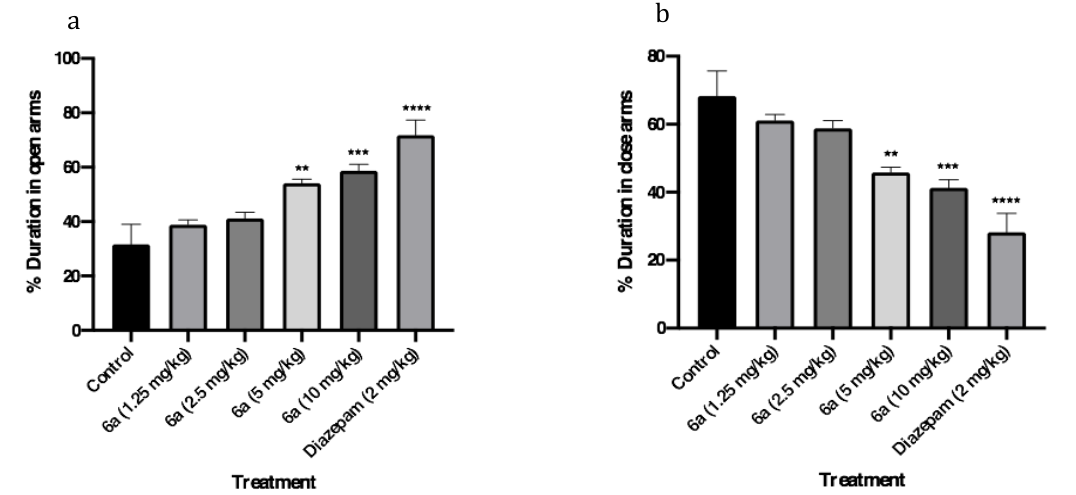
Figure 5: Anti-anxiety effects of the novel compound ( 6a ) using EPM test. ( a ) percentage of duration in open arms, ( b ) percentage of duration in close arms. Data are presented as mean ± SEM. In all groups n=8. ** represents P <0.01 compared to the control group. *** represents P <0.001 compared to the con- trol group. **** represents P <0.0001 compared to the control